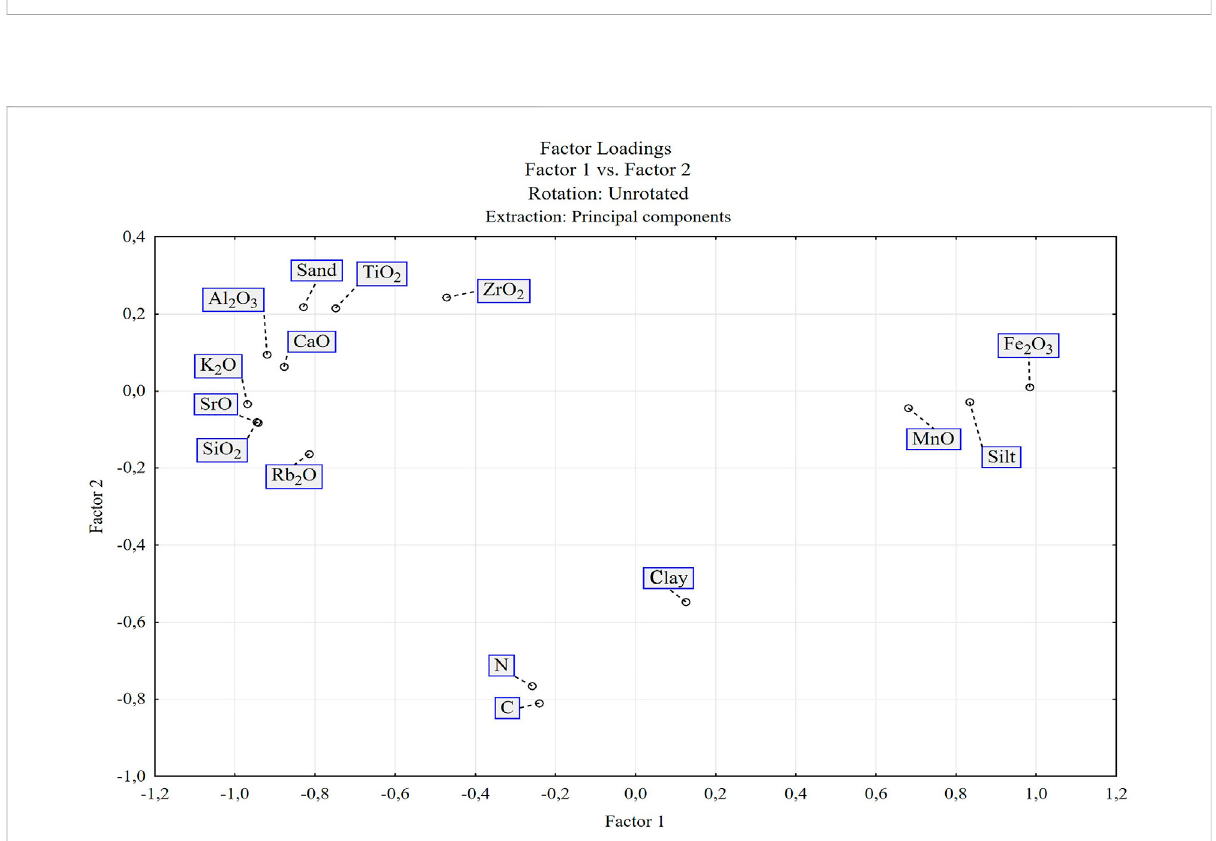
FIGURE 7 PCA analysis for the main chemical compounds and particle-size distribution in